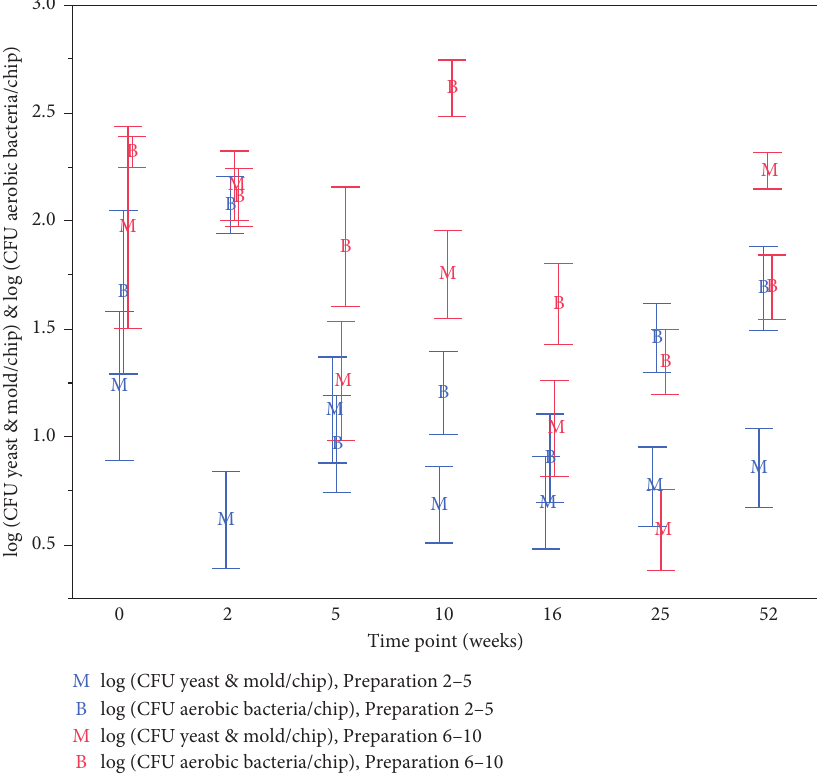
Figure 2: Mean microbial load of the persimmon chips over the 1-year course of the storage study. The mean was calculated from the log- transformed plate counts per slice from both packaging types. Each error bar is constructed using 1 standard error from the mean. CFU � colony-forming units. Table 3: Instrumental texture